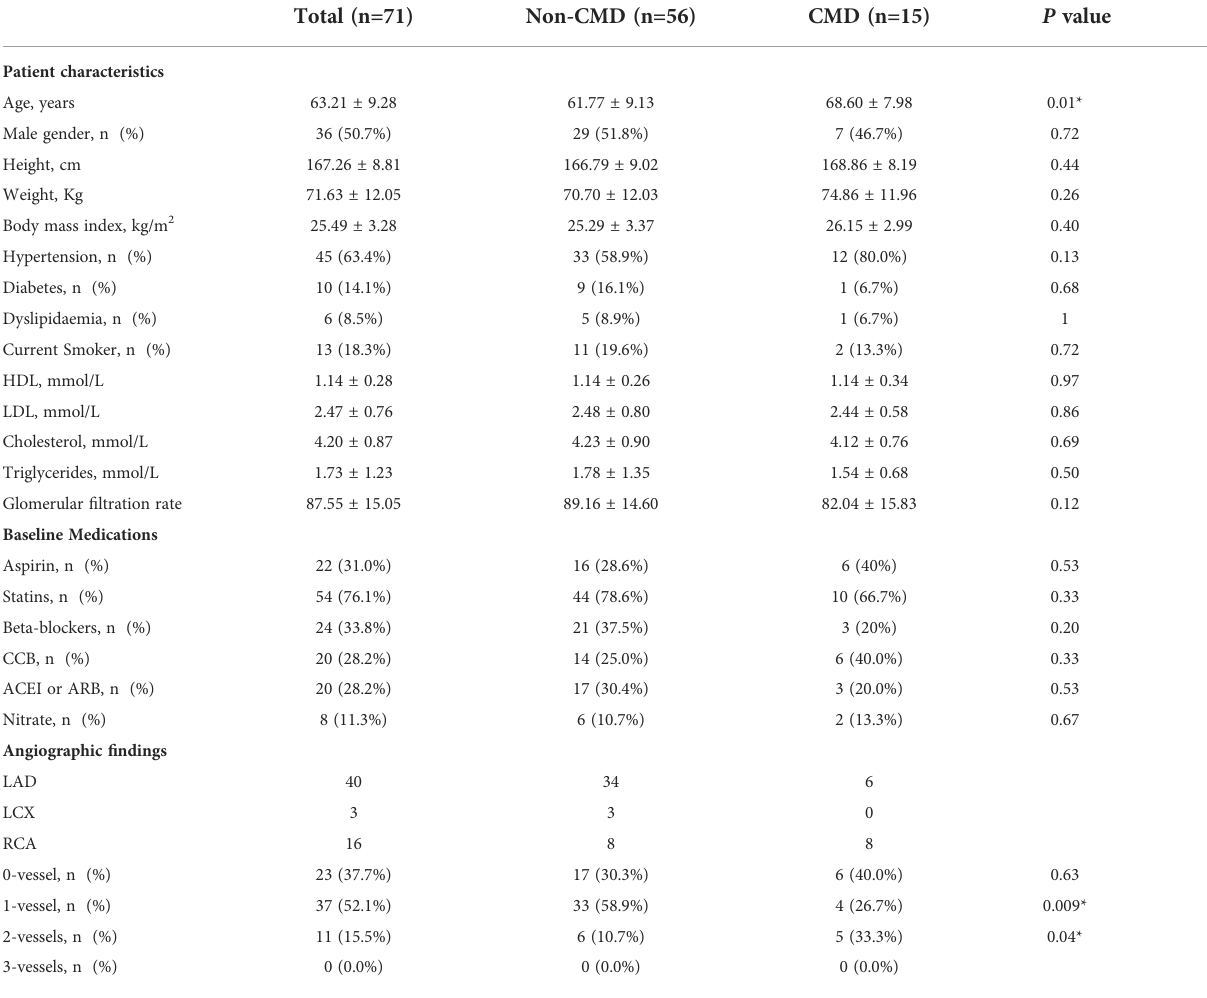
TABLE 1 Clinical characteristics of the study population (n =